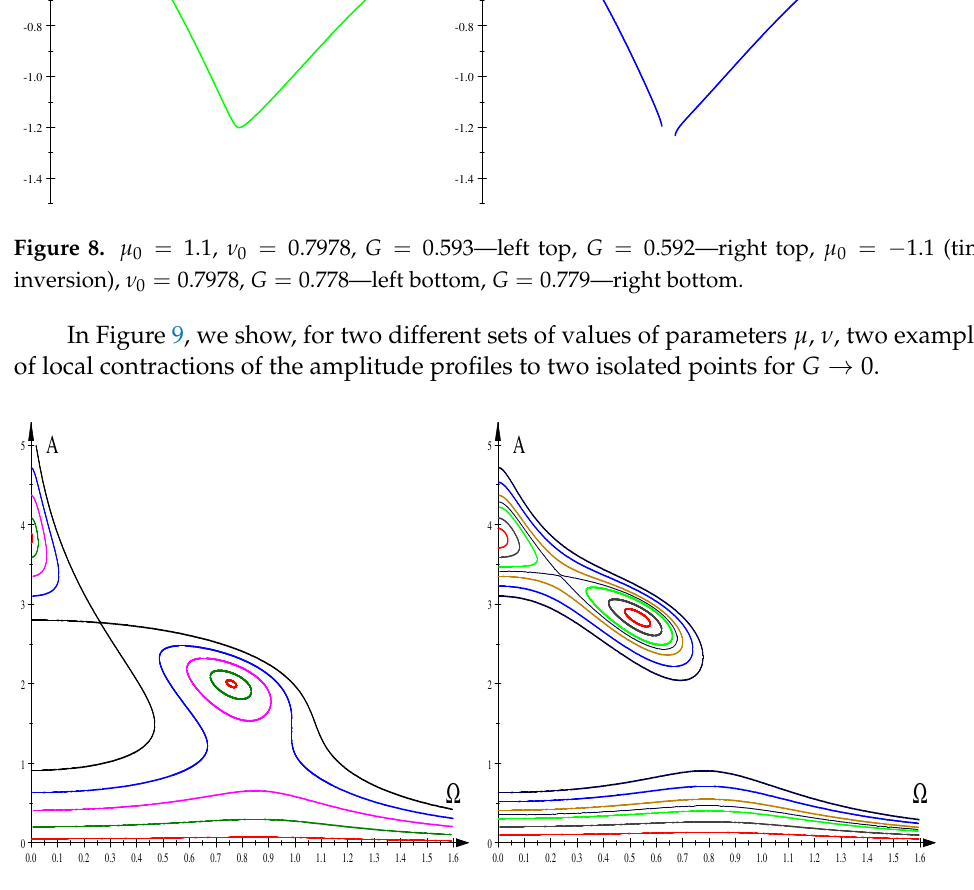
Figure 9. Two metamorphoses. Left figure: µ = 0.75, ν = 1, G = 0.05—red, 0.2—green, 0.4—magenta, 0.6—blue, 0.8191—black. Right figure: µ = 0.85, ν = 0.5, G = 0.1—red, 0.2—gray, 0.3—green, 0.3445—black, 0.4—sienna, 0.5—blue, 0.6—navy. Bifurcation diagrams for the left amplitude profiles in Figure 9 are shown in Figure 10 (colours of stable branches correspond to colours of amplitude profiles in the left Figure